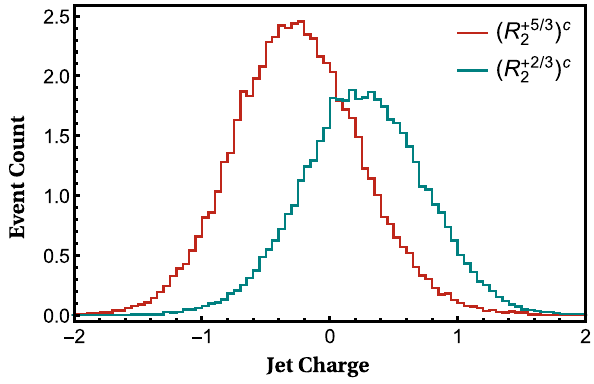
with mass 70 GeV 2